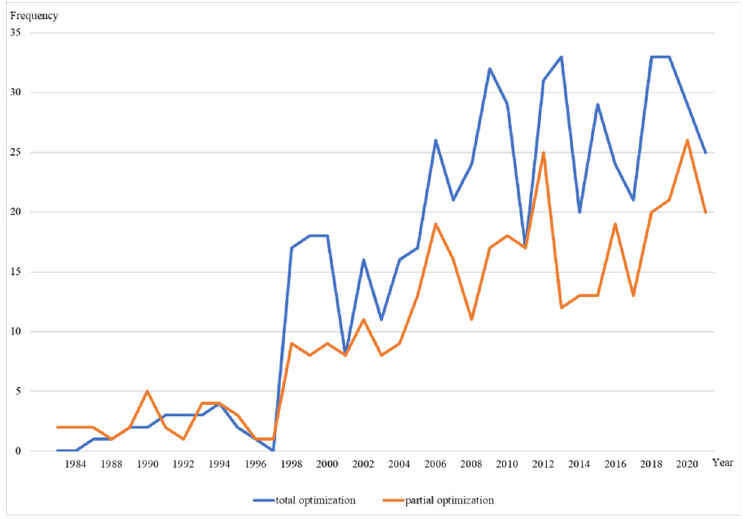
Figure 1. Frequency of mention about total optimization and partial